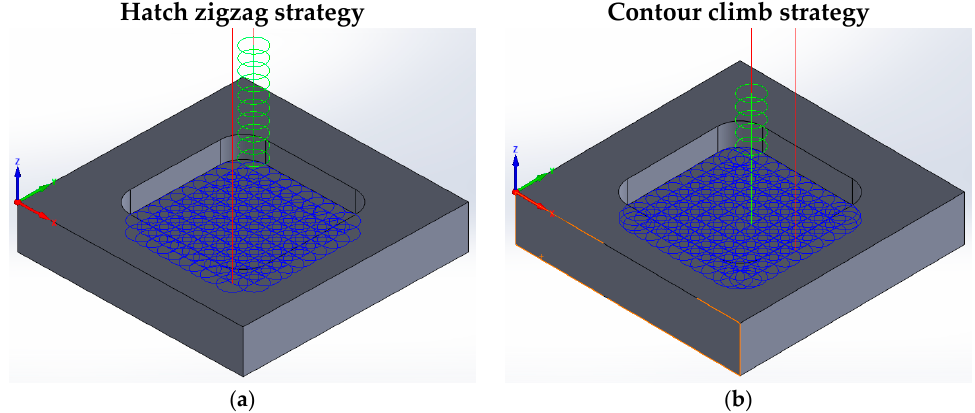
Figure 3. Cutter path strategies in pocket milling: ( a ) Hatch zigzag; ( b ) Contour climb.